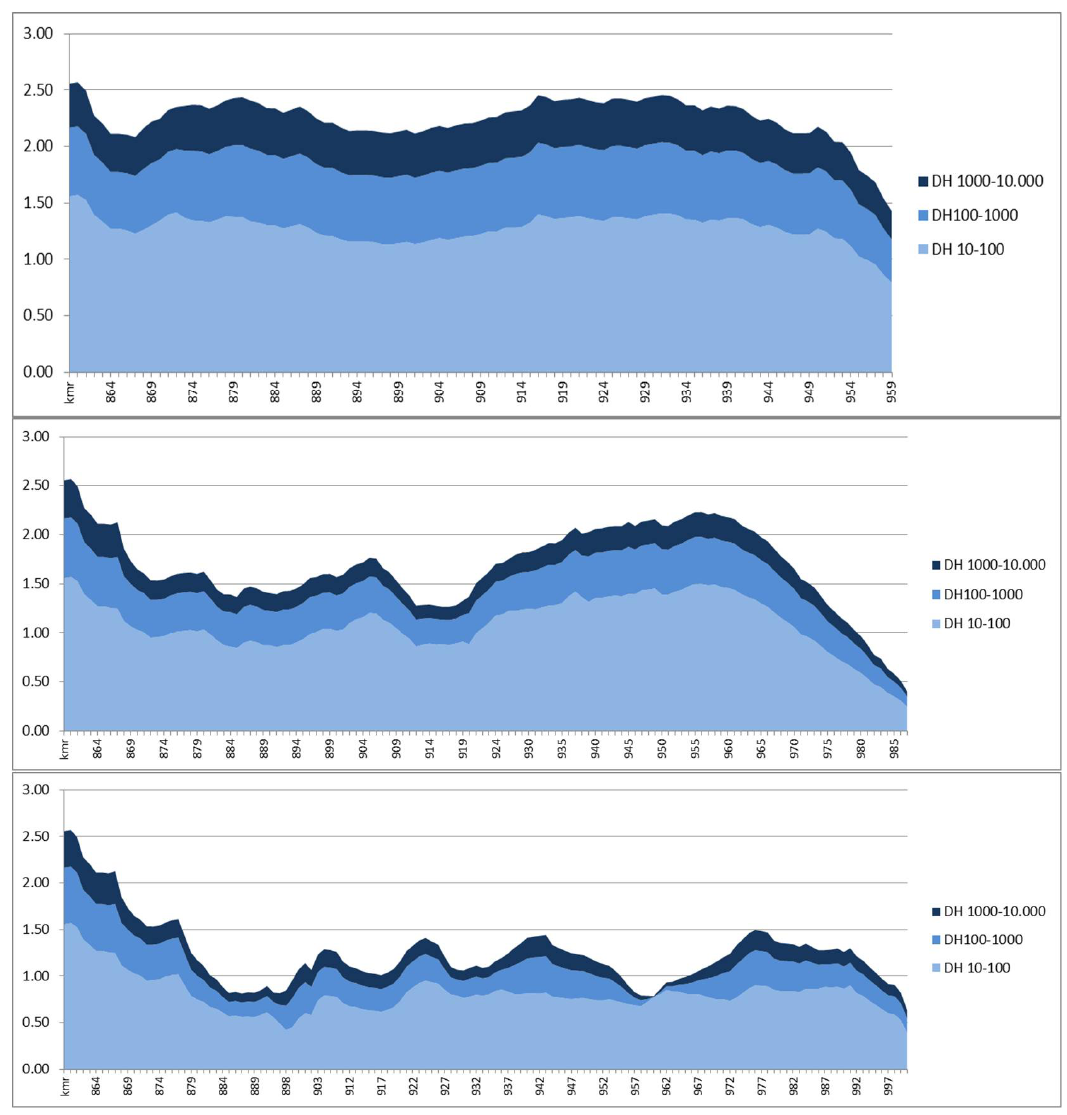
Figure 8. Cumulative decimation heights for respectively Bovenrijn-Waal ( top ), Bovenrijn-Pannerdensch Canal-Nederrijn/Lek ( center ) and Bovenrijn-Pannerdens Canal-IJssel ( bottom ). Mark that the rivers have different lengths.